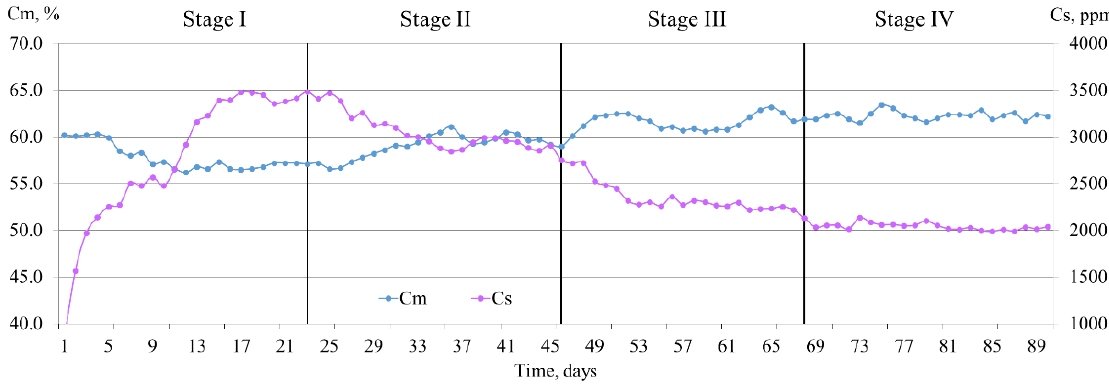
Figure 3. Changes of C m and C s values during experiments.